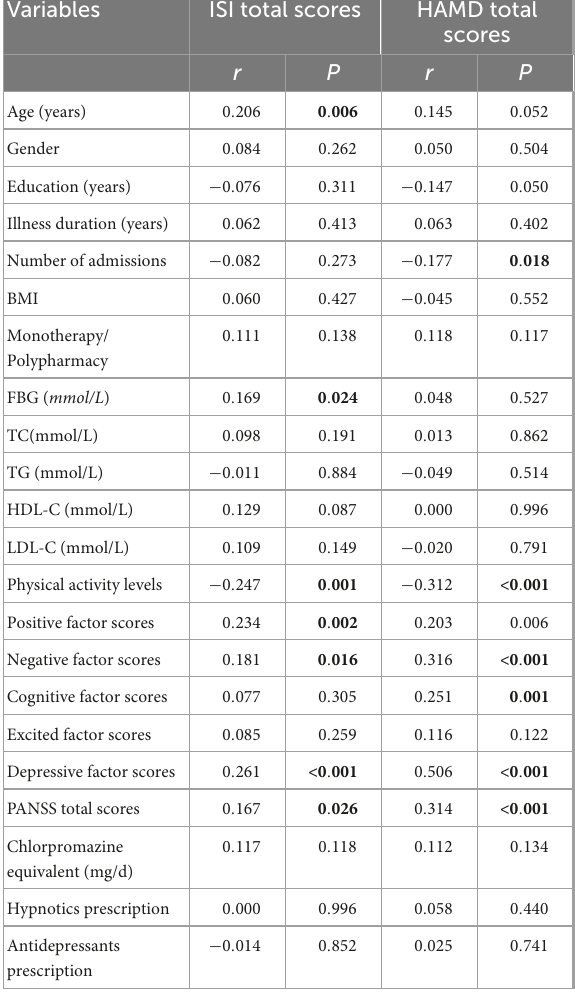
TABLE 3 Demographic and clinical variables independently associated with insomnia symptoms by binary logistic regression analysis.